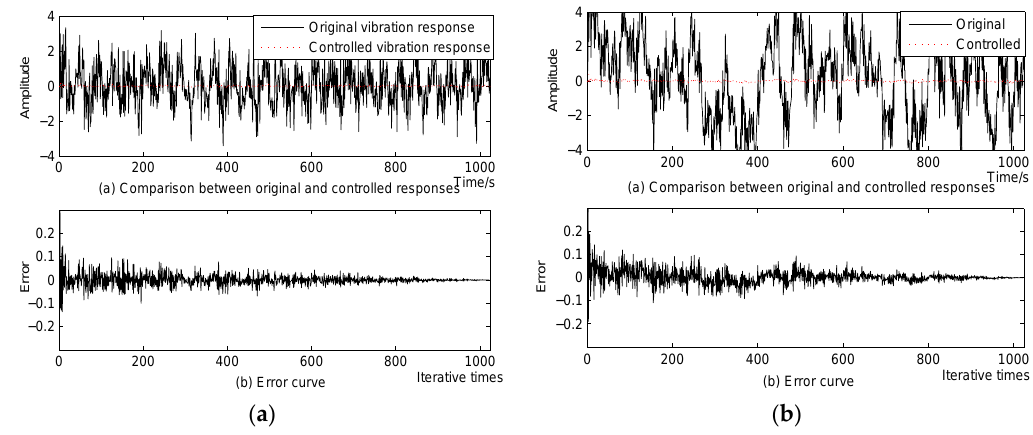
Figure 7. Control result of spindle actuated by: ( a ) single frequency sinusoidal signal ( b ) multifrequency sinusoidal signal.